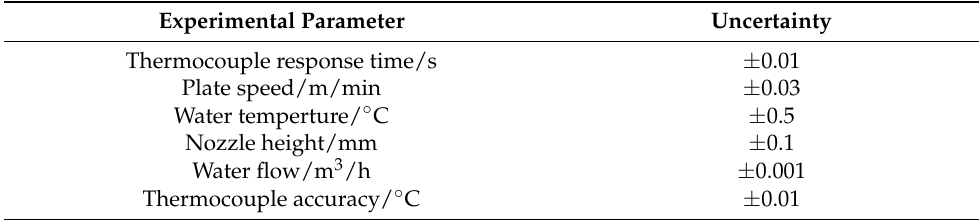
Table 3. Uncertainties in the experimental